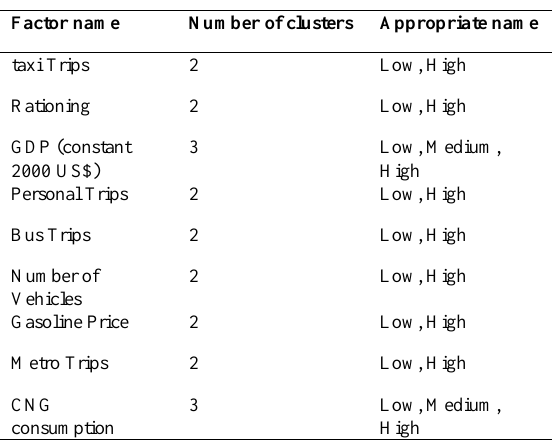
Table 4. Factors discretized to appropriate number of clusters by two-step clustering